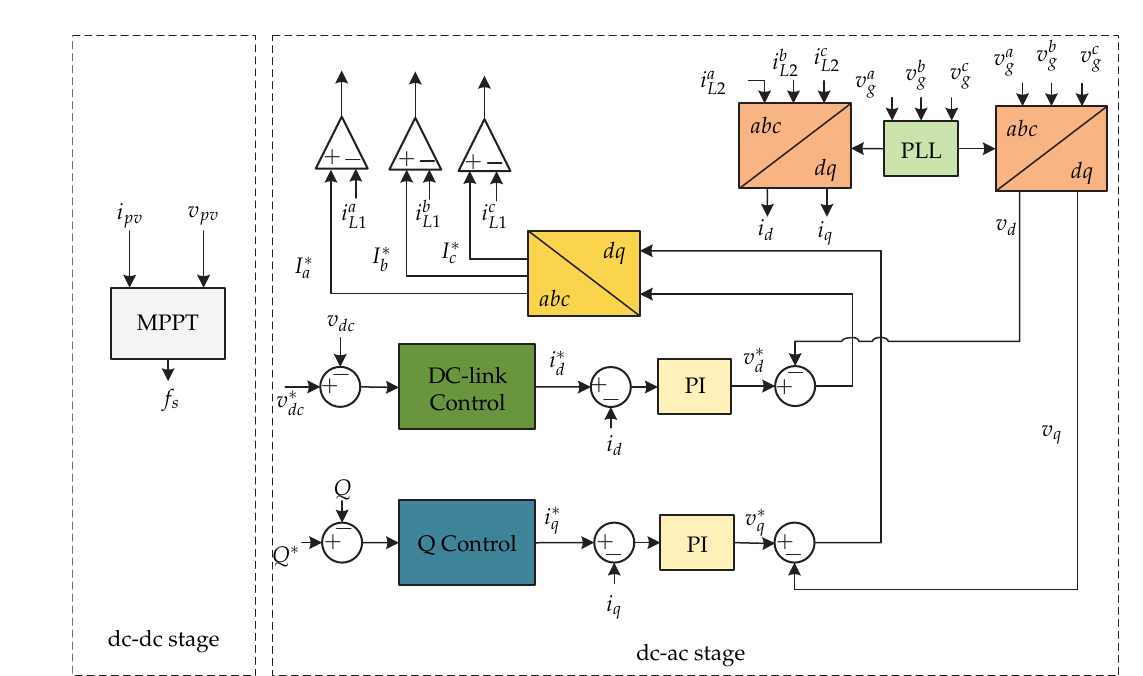
Figure 7. Control strategy proposed in [15–17].